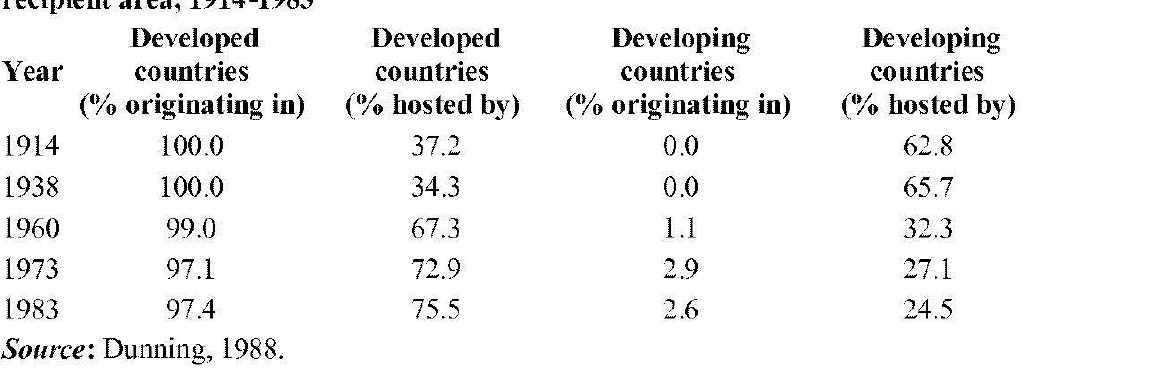
Table 1. Estimated stock of accumulated direct investment by area of origin and recipient area, 1914-1983 Developed Developed Developing